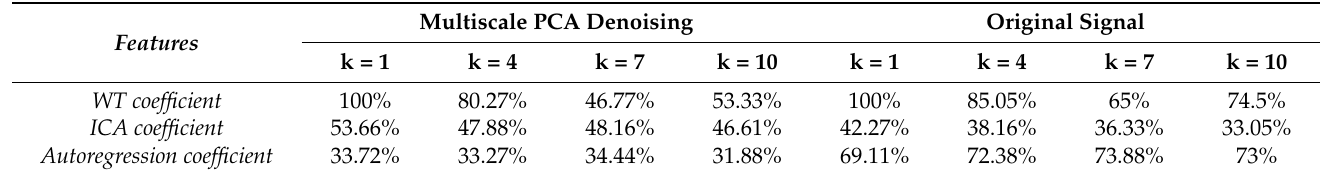
Table 1. The KNN classification